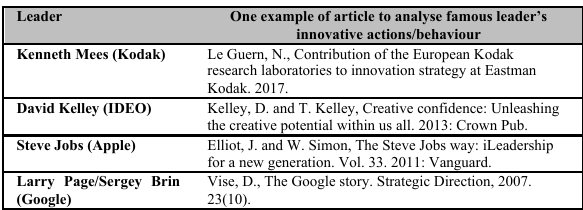
Table 1. Example of historical material for famous leaders Leader